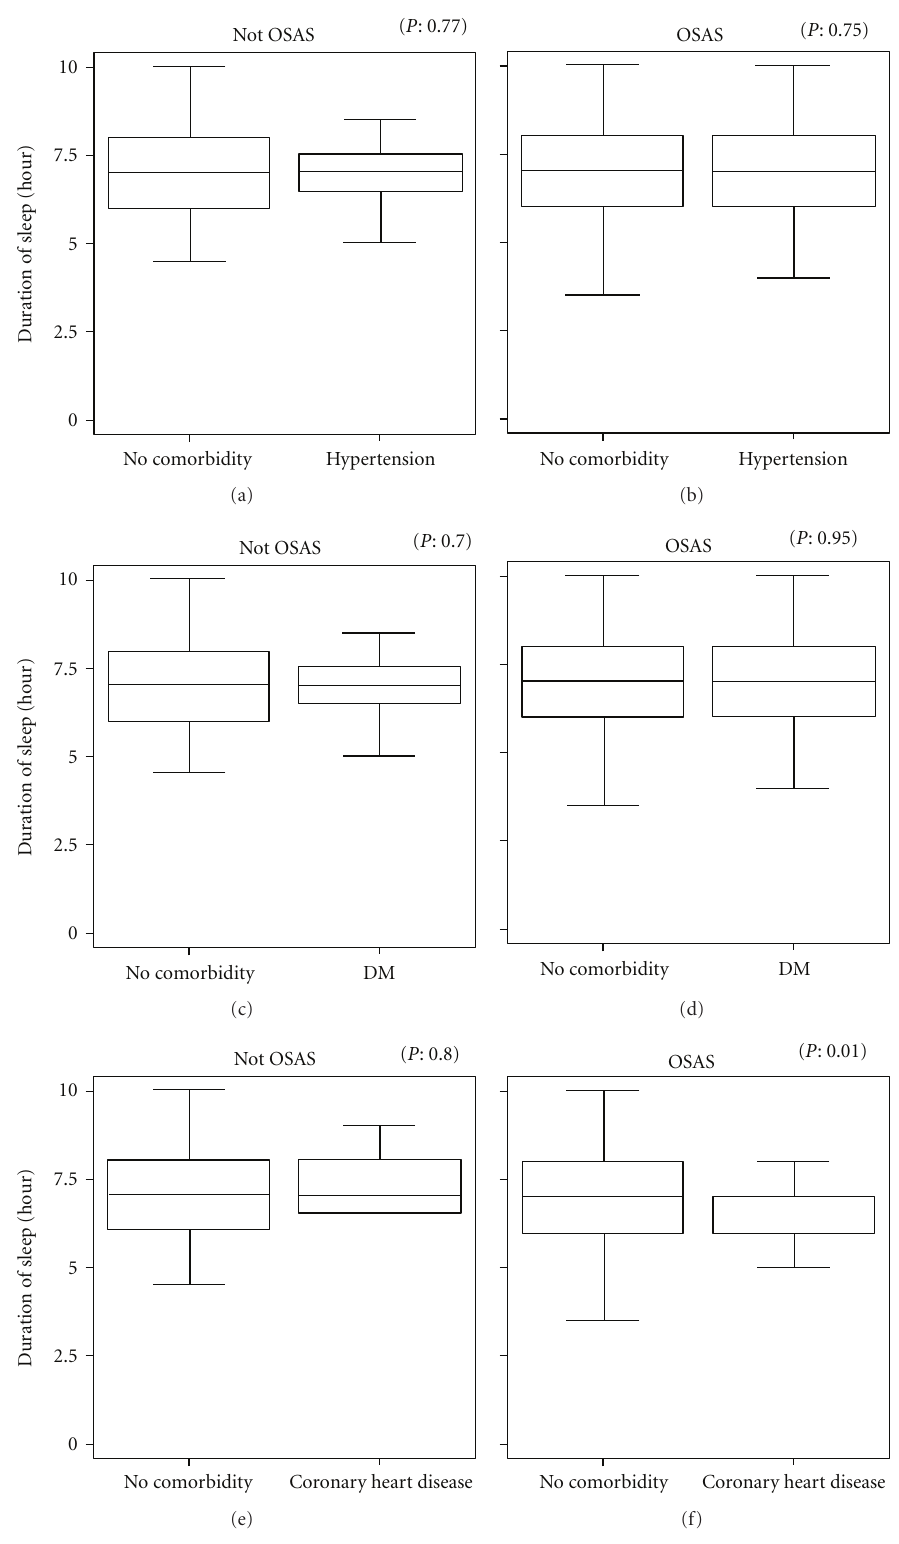
Figure 2: Boxplot graph of the distribution of duration of sleep in HT, DM, and CHD comorbidity groups compared to no comorbidity group in the subjects without OSAS (Not-OSAS) in graphs a, c and e and in the subjects with OSAS (OSAS) in graphs b, d and f: HT: hypertension, DM: diabetes mellitus, CHD: coronary heart disease, and OSAS: obstructive sleep apnea syndrome. Mann-Whitney U test was used in the